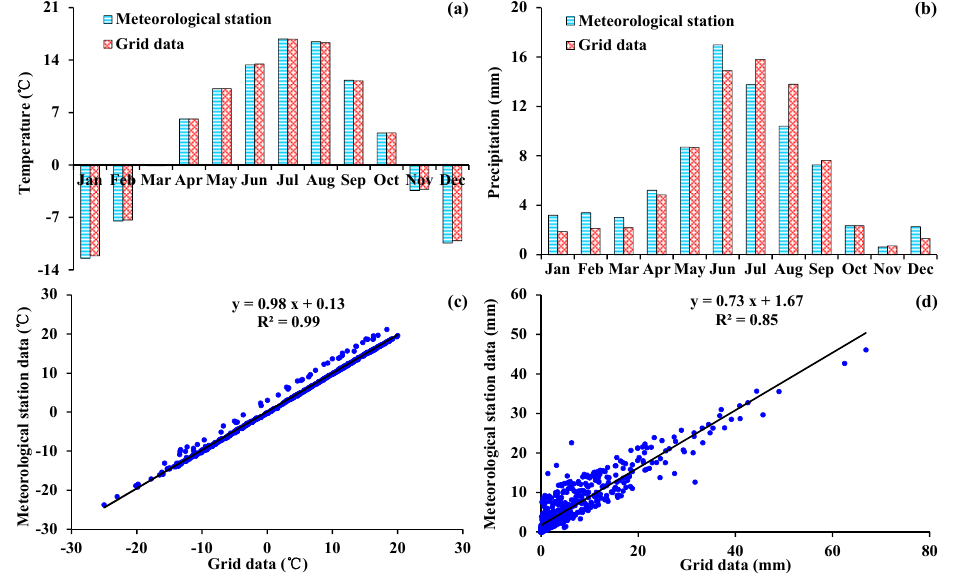
Figure 2. Comparison of the meteorological station-based air temperature and precipitation with the nearest grid data; ( a ) mean monthly air temperature; ( b ) mean monthly precipitation; ( c ) correlation between the meteorological station monthly air temperature and that of the nearest grid data; ( d ) correlation between the meteorological station monthly precipitation and that of the nearest grid data. R 2 : coefficient of determination.